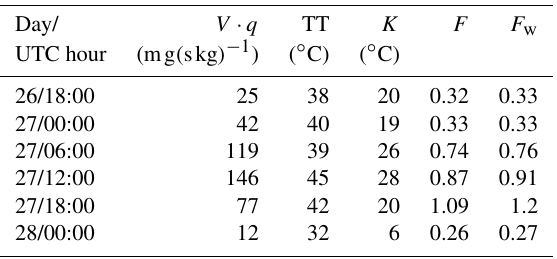
Table 3. Time variation for several meteorological indices along 26, 27 and 28 February 2010. TT and K are the total totals and K instability indices; V · q (mg ( skg ) − 1 ), F , and F w are the merid- ional moisture flux, Froude number, and moist Froude number at the 850hPa pressure level.